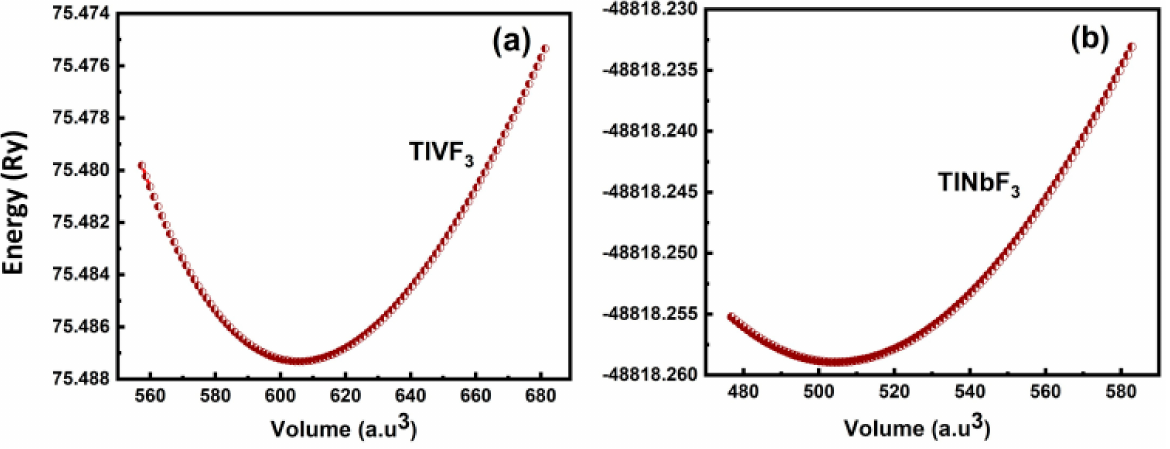
Figure 2. Total energy vs. volume of cubic ( a ) TlVF 3 ( b ) TlNbF 3 . Table 1. Structural parameters of TlVF 3 and TlNbF 3 using TB-mBJ approach in which a 0 shows optimized lattice constant in angstrom (Å), B is the bulk modulus in GPa, B (cid:48) depict the derivative of bulk modulus in GPa, and V o in (a.u) 3 is the optimized unit cell volume.